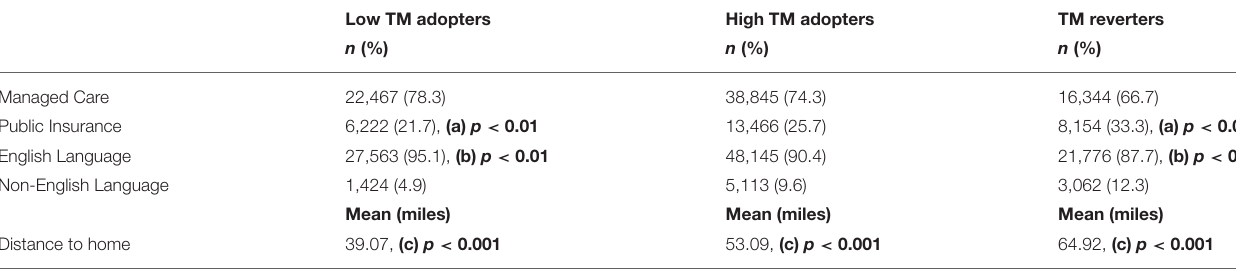
TABLE 2 | Patient factors among pediatric subspecialty TM visits.